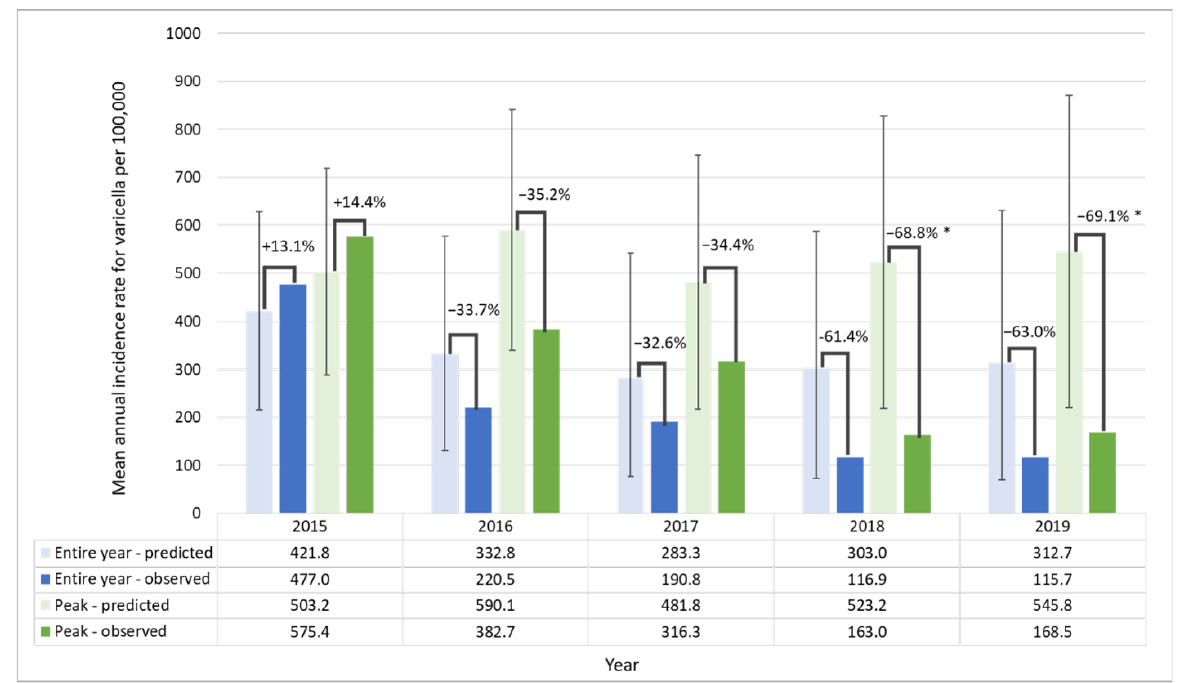
Figure 4. Observed and predicted mean annual incidence rates for varicella in Argentina and relative difference between them, in the entire year and peak periods, in the overall population. * Periods where observed values are not within the 95% PI of predicted mean annual incidence rate. Proportion of target population eligible for vaccination: less than 25% in 2015; 25–50% in 2016; 50–75% in 2017; 75–100% in 2018 and 100% in 2019. Vaccination coverage in target population: 44.8% in 2015; 74.4% in 2016; 76.8% in 2017; 81.0% in 2018 and 77.6% in 2019. Non-peak period, all months exclud-